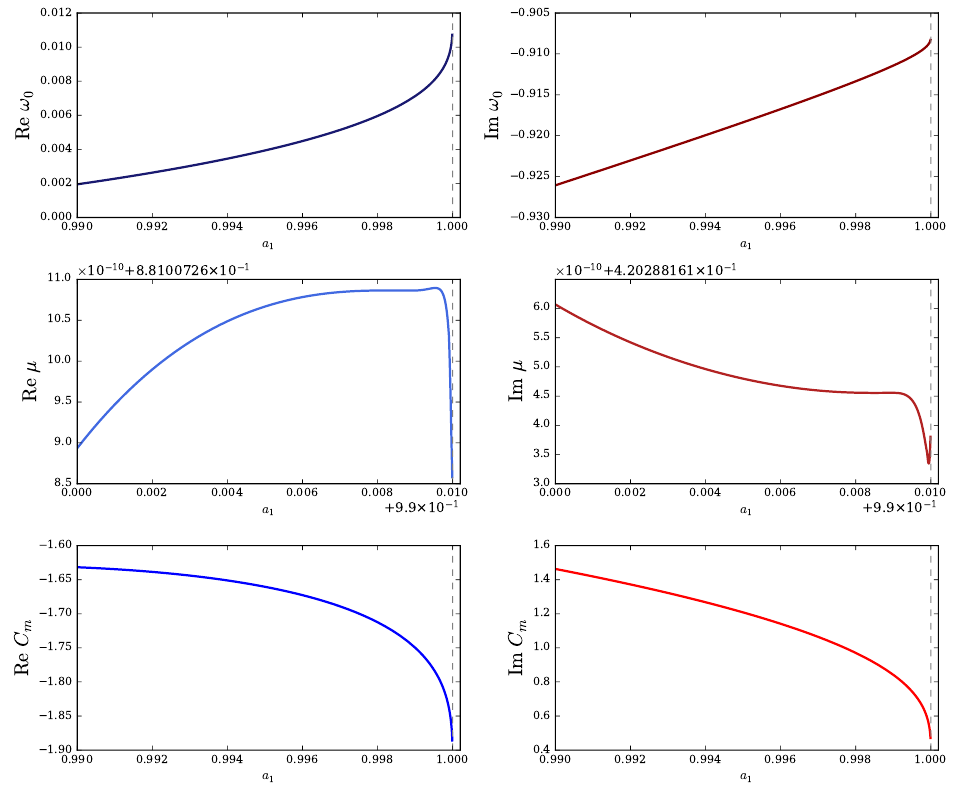
Figure 1 . Quasinormal frequencies ! 0 , separation constant C m and the parameter (cid:22) for the electric polarization in the ultraspinning limit. Note that the change of the separation parameter (cid:22) is very small, in the range of variation of a 1